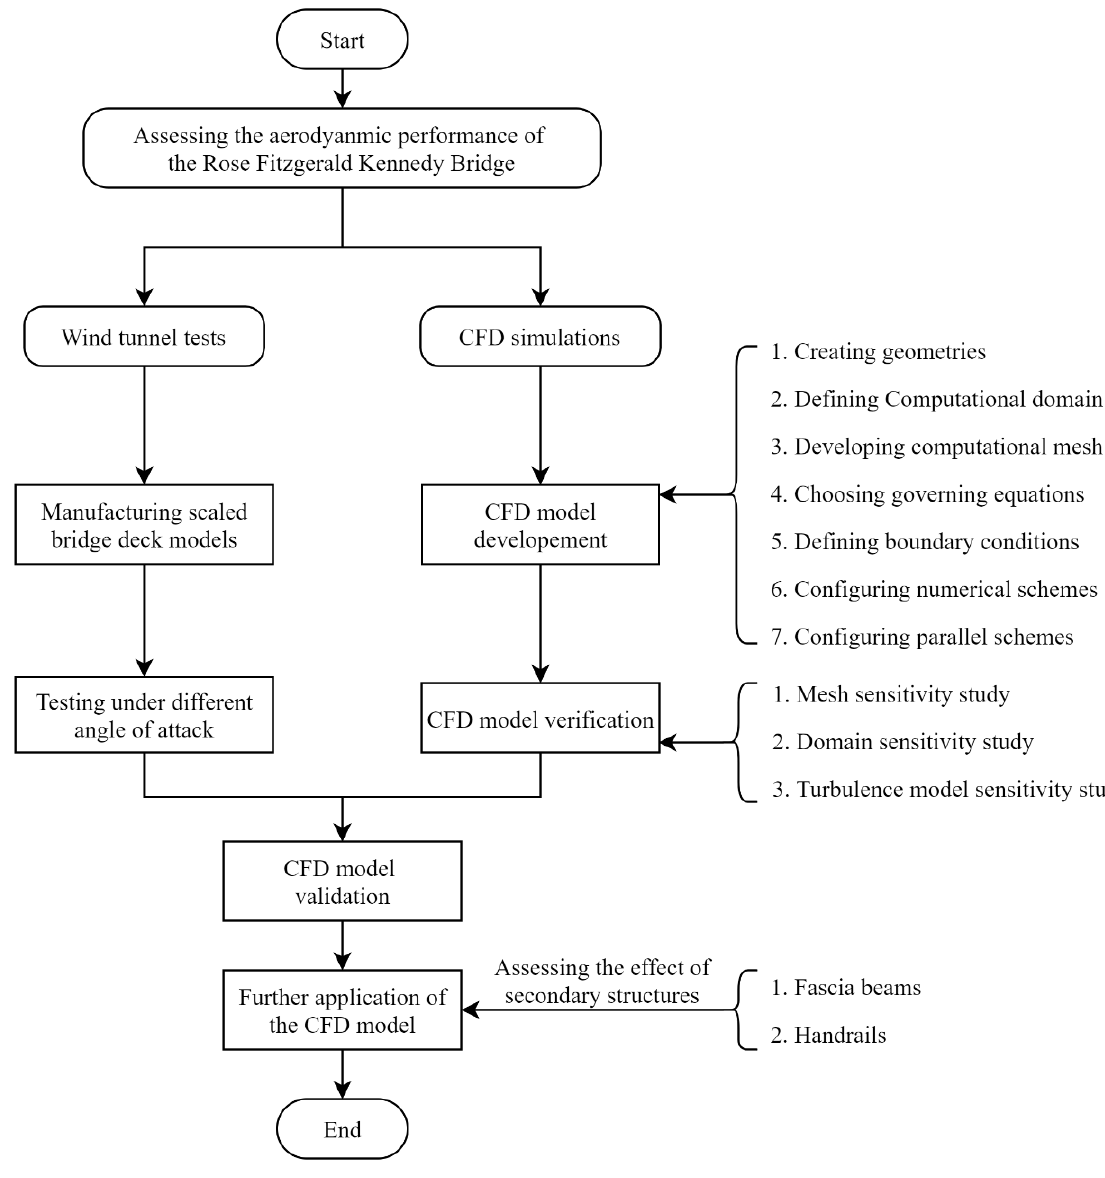
Figure 1. Procedures of the study.